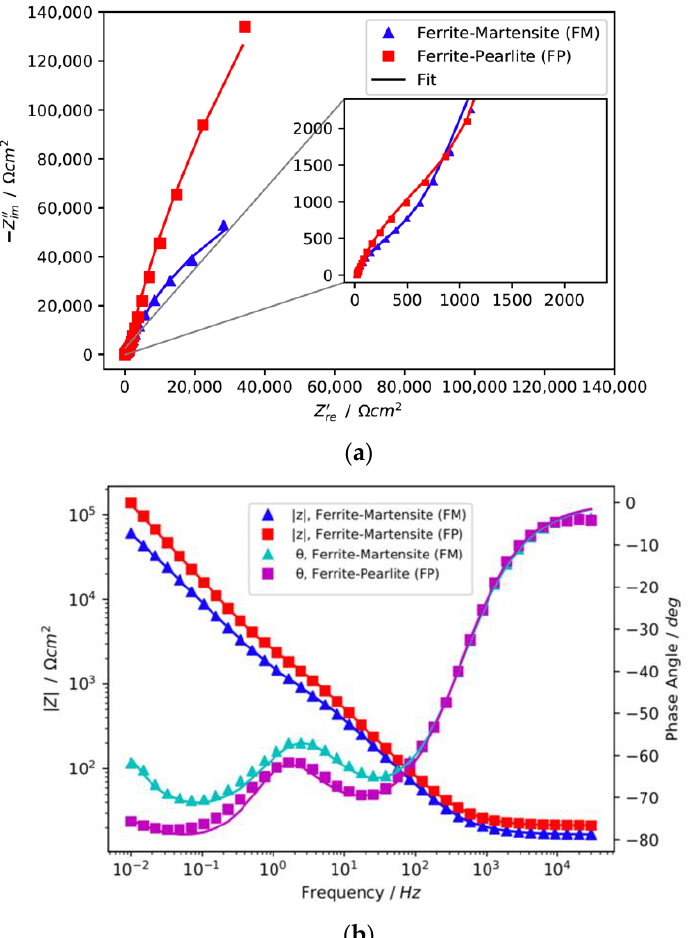
Figure 4. Nyquist ( a ) and Bode ( b ) plots of dual phase microstructures obtained with EIS experiments in 0.1 M NaOH solution. Samples were pre-passivated by potentiostatic polarisation at 0.2 V (vs. Ag/AgCl) for 6 h in 0.1 M NaOH solution.